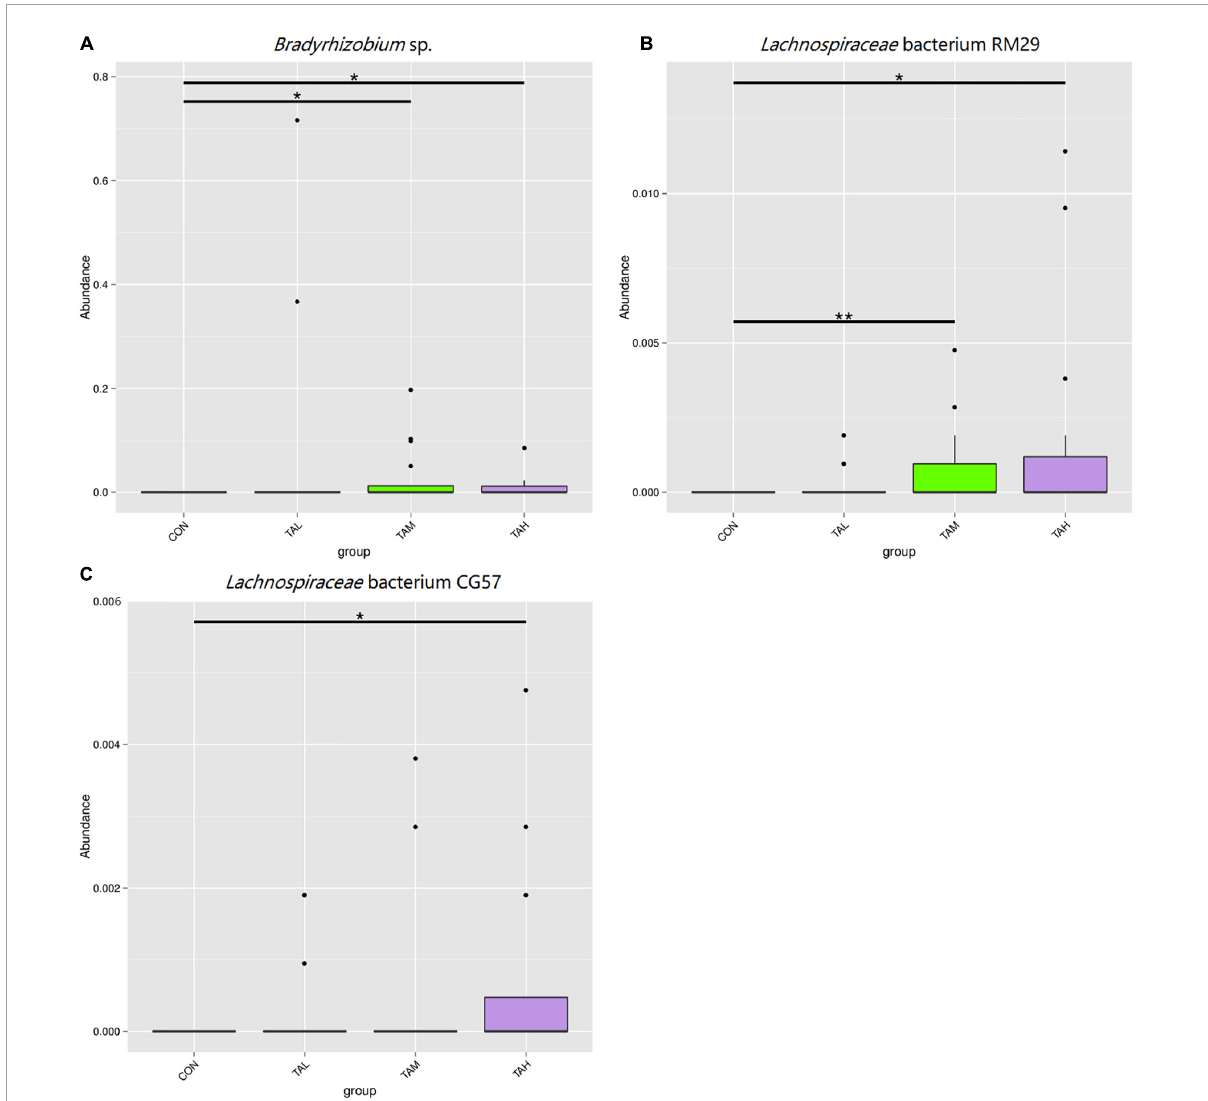
FIGURE4 Differential bacterial species in the rumen fluid across the four treatments. (A) Bradyrhizobium sp. (B) Lachnospiraceae bacterium RM29. (C) Lachnospiraceae bacterium CG57. *Means that the difference between two treatments was significant ( P < 0 . 05). **Means that the difference between two treatments was highly significant ( P < 0 .